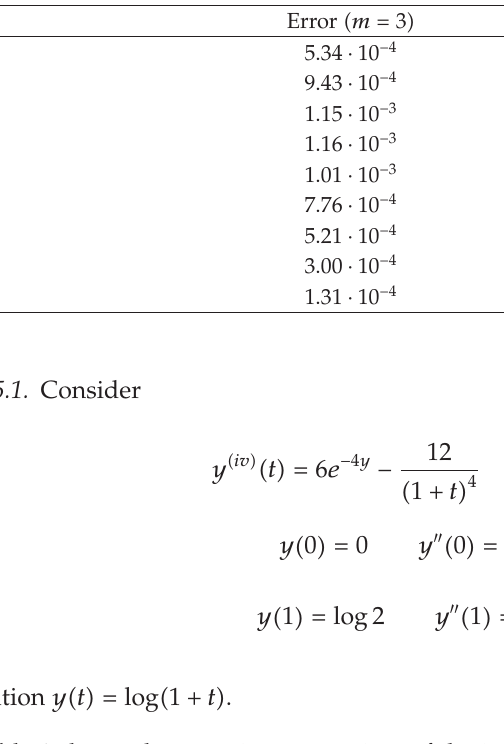
Table 1: Problem (cid:4) 5.2 (cid:5) —Example